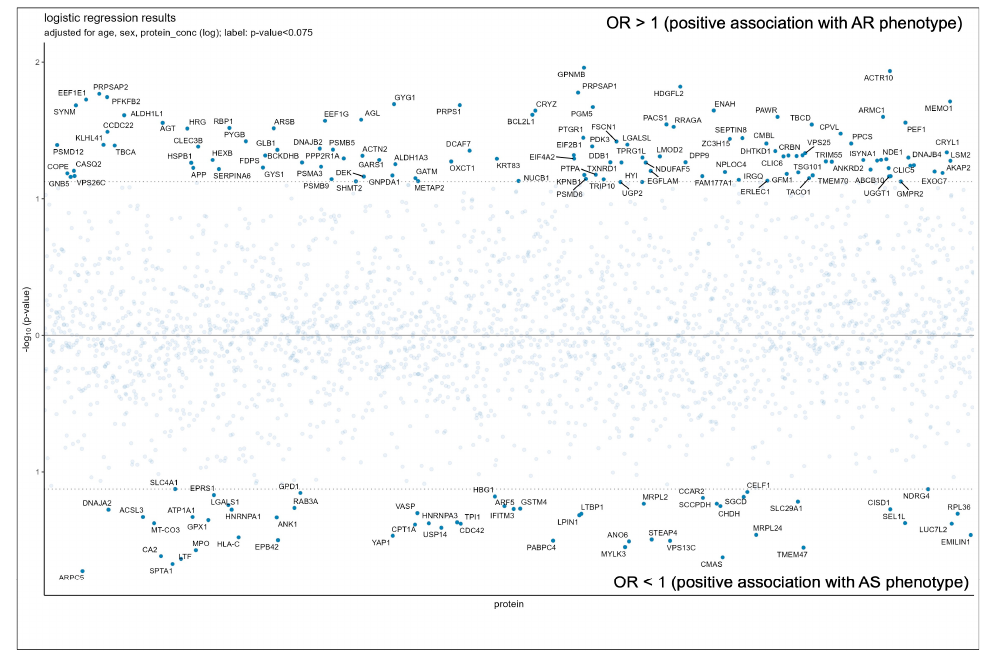
Figure 1. Aortic regurgitation and aortic stenosis-associated proteins: p < 0.075. AR: aortic regurgita- tion; AS: aortic stenosis; OR: Odds ratio, i.e., chance to be assigned to the aortic regurgitation or the aortic stenosis group when protein intensity is